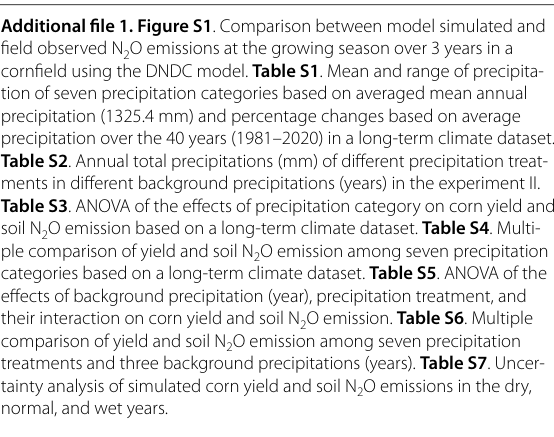
Table S2 . Annual total precipitations (mm) of different precipitation treat- ments in different background precipitations (years) in the experiment II. Table S3 . ANOVA of the effects of precipitation category on corn yield and soil N 2 O emission based on a long-term climate dataset. Table S4 . Multi- ple comparison of yield and soil N 2 O emission among seven precipitation categories based on a long-term climate dataset. Table S5 . ANOVA of the effects of background precipitation (year), precipitation treatment, and their interaction on corn yield and soil N 2 O emission. Table S6 . Multiple comparison of yield and soil N 2 O emission among seven precipitation treatments and three background precipitations (years). Table S7 . Uncer- tainty analysis of simulated corn yield and soil N 2 O emissions in the dry, normal, and wet